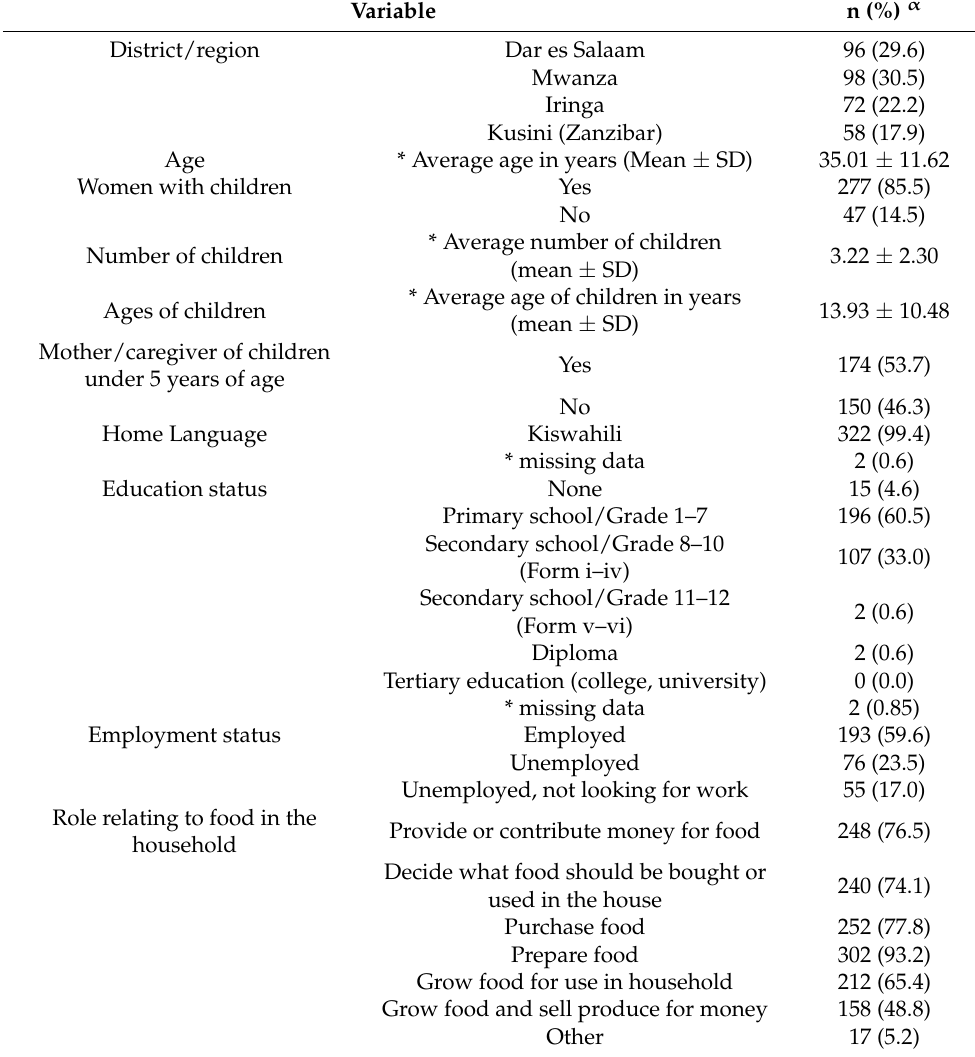
Table 2. Sociodemographic characteristics of